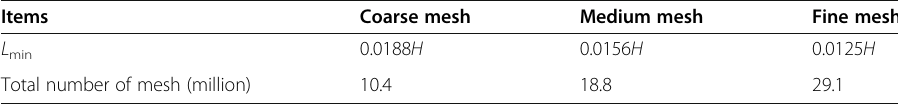
Table 3 Details of the three types of the mesh Items